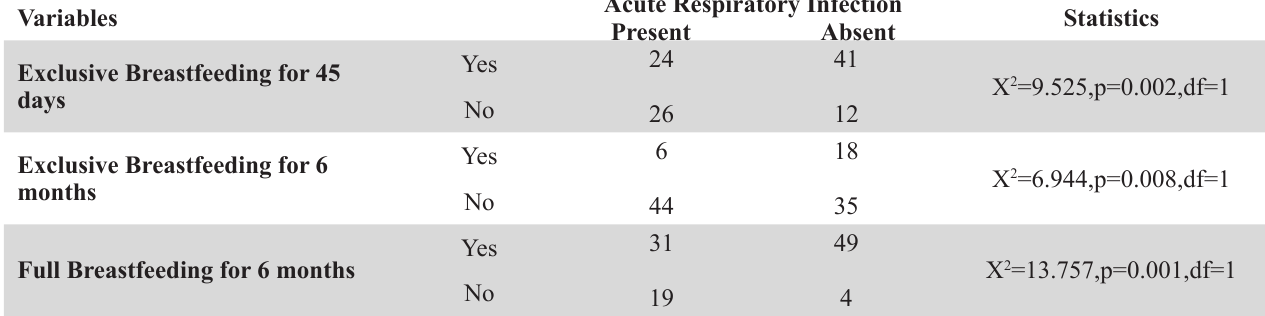
Table 1. Incidence of Acute Respiratory infection in differently breastfed infants Variables